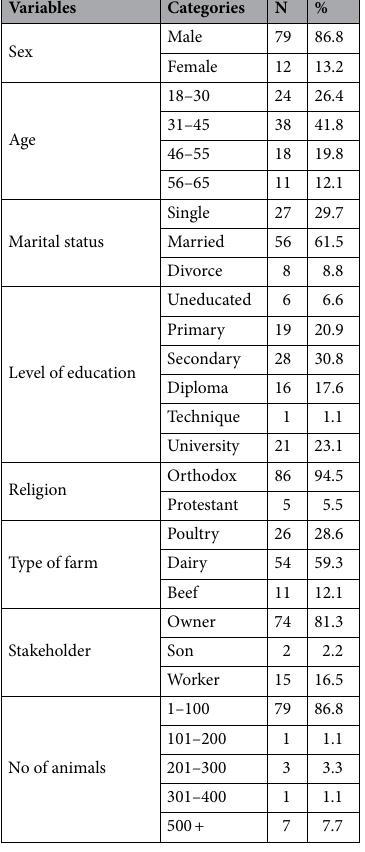
Table 1. Demographic characteristics of animal farm owners/workers (N =